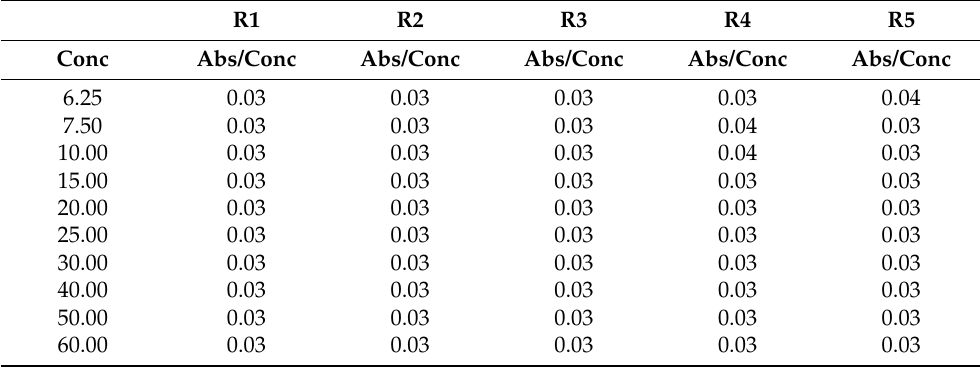
Table 5. Linearity of the spectrophotometric method using ANOVA test for the response factor of the calibration curves.